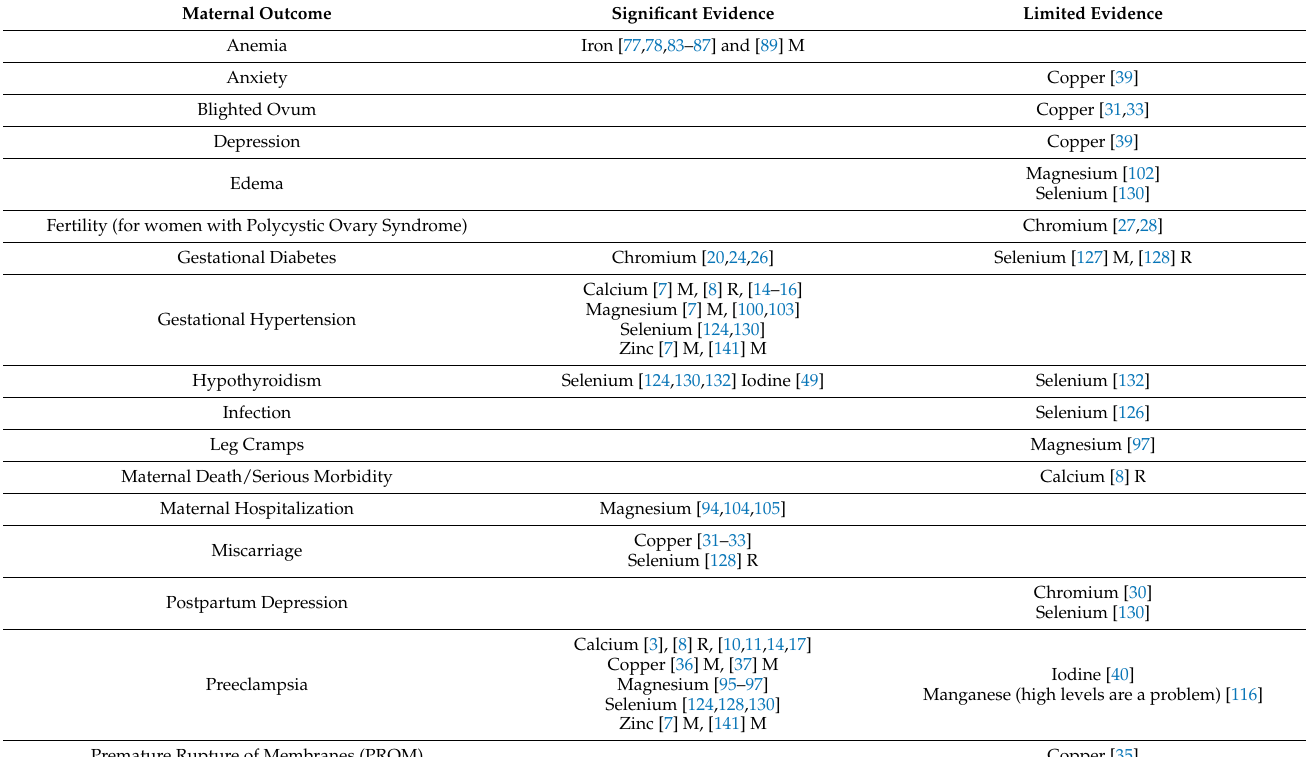
Table 1. Relationship of maternal health complications to mineral status. Superscripts of M indicate meta-analyses, and R indicates a Review of multiple studies [3,7,8,10,11,14–17,20,24,26–28,30–33,35–37,39,40,49,94–97,100,102–105,116,124,126–